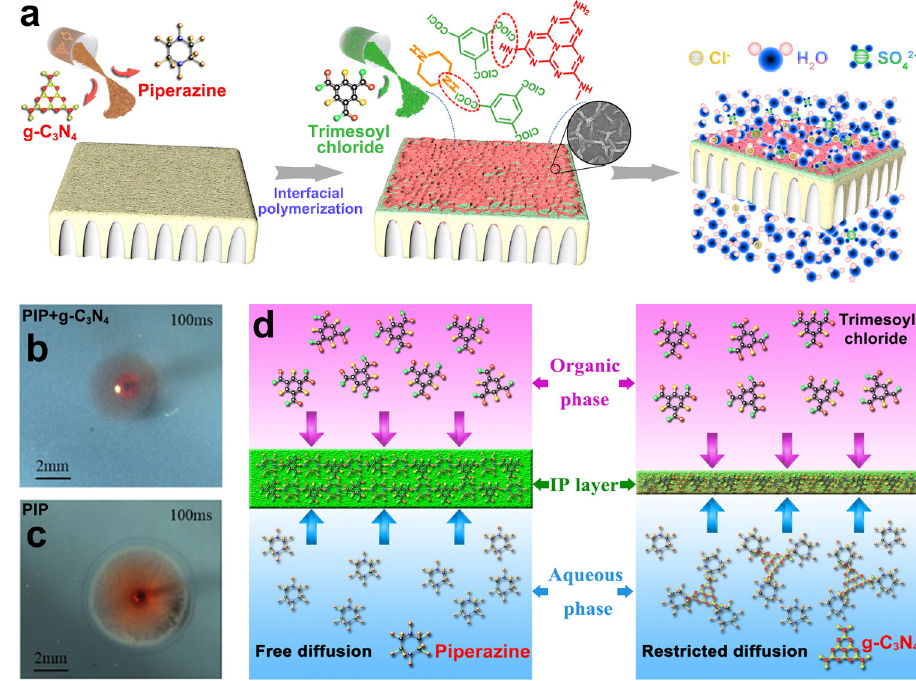
Fig. 1 | Preparation of NF membranes regulated by g-C 3 N 4 . a Schematic illus- tration of the g-C 3 N 4 -regulated membrane preparation process. b Optical photo- graph capturing the PIP+g-C 3 N 4 +TMC reaction at 100ms. c Optical photograph